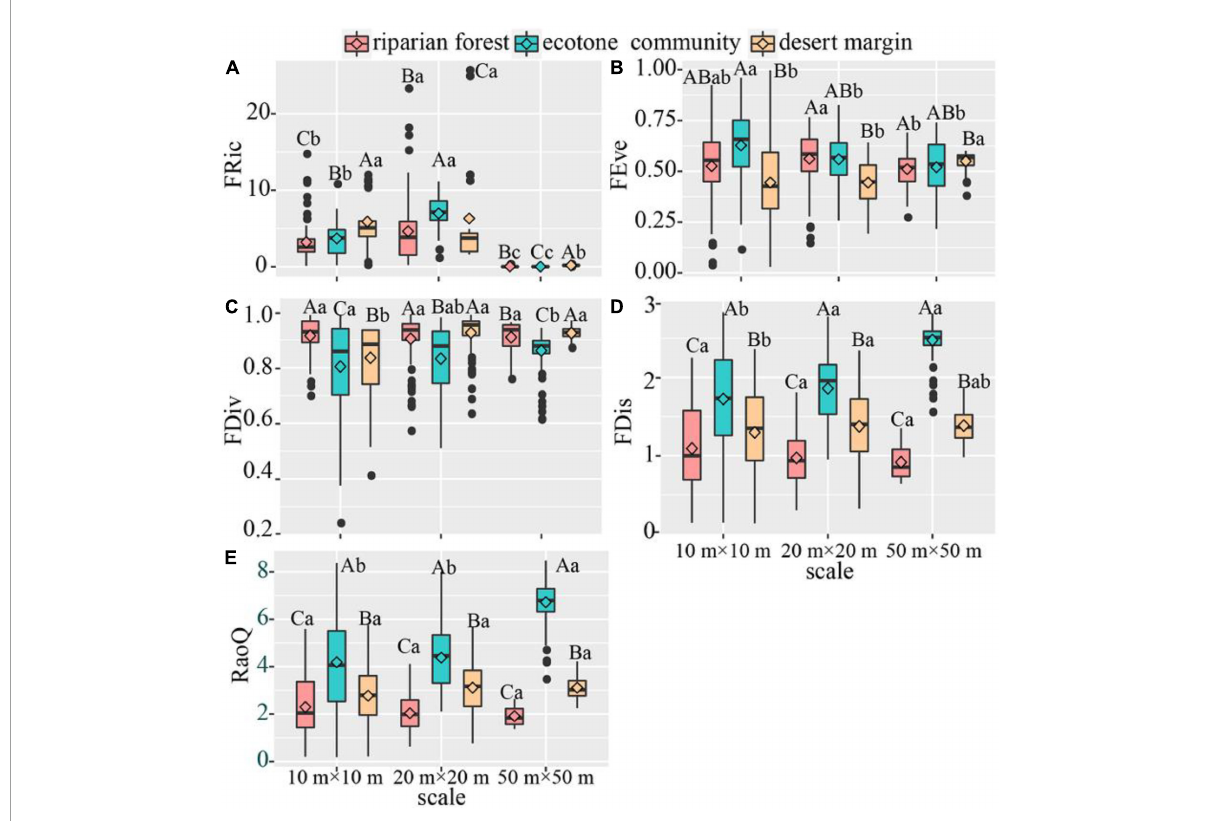
FIGURE4 Variation of functional diversity across spatial scales. The instruction of capital and lower-case letters see Figure 2 . (A) FRic. (B) FEve. (C) FDiv. (D) FDis. (E) RaoQ. P <